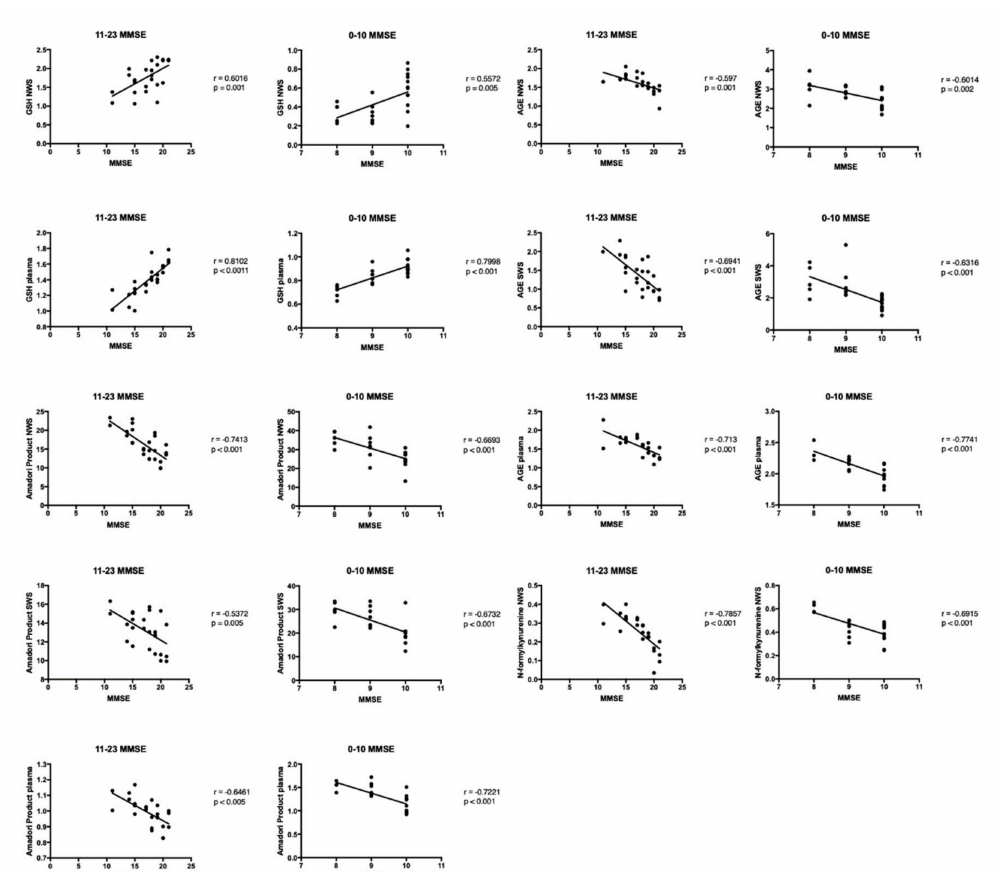
Figure 4. Correlations between oxidative stress biomarkers and clinical status in dementia patients. Abbreviations: AGE—advanced glycation end products; GSH—reduced glutathione; MMSE—Mini Mental State Examination; NWS—non-stimulated whole saliva; SWS—stimulated whole